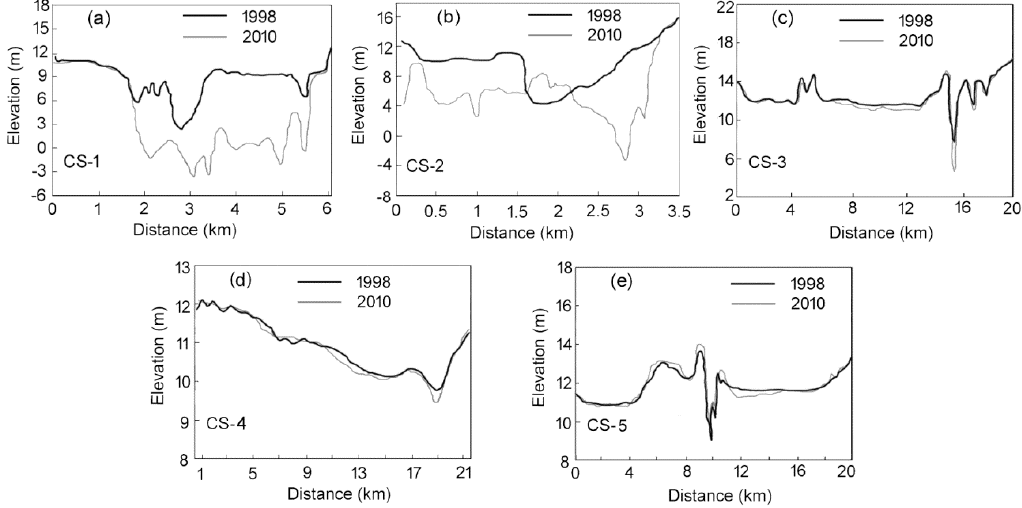
Figure 4. Profile changes at the five cross-sections in Poyang Lake.